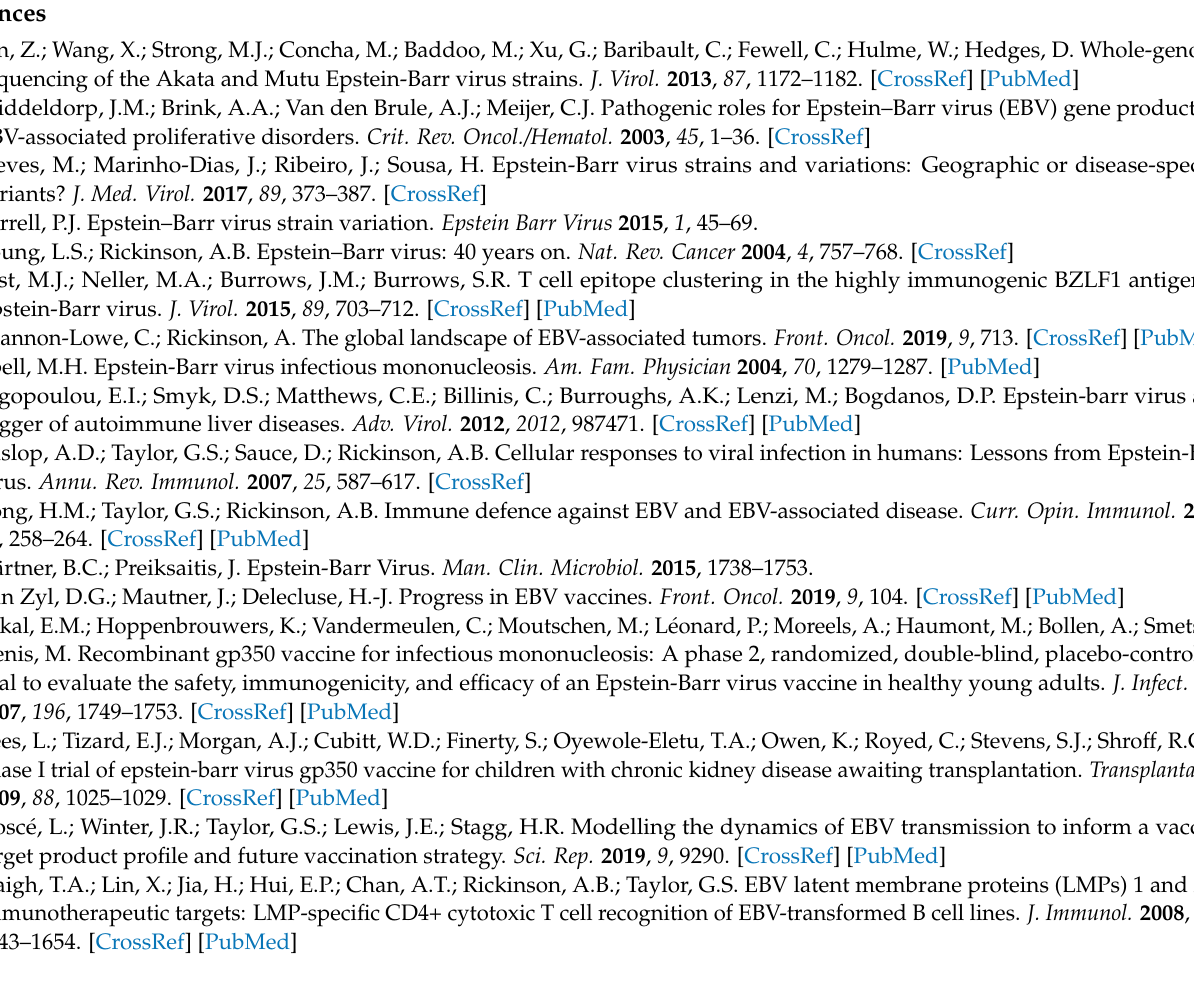
and Procheck. (A) the 3D model of HLA molecule (B) The ERRAT score of 97.2 (C) Prosa-Web quality score − 5.52 and (D) Ramachandran plot by Procheck shows 90.4% residues in most favored region, 9% in additional allowed region, none of the residues in generously allowed region and 0.6% in disallowed region. Figure S3. Selected HTL epitopes docking complex with respective HLAs. The epitope is shown in red color whereas the human leukocytes antigens are presented in dark blue